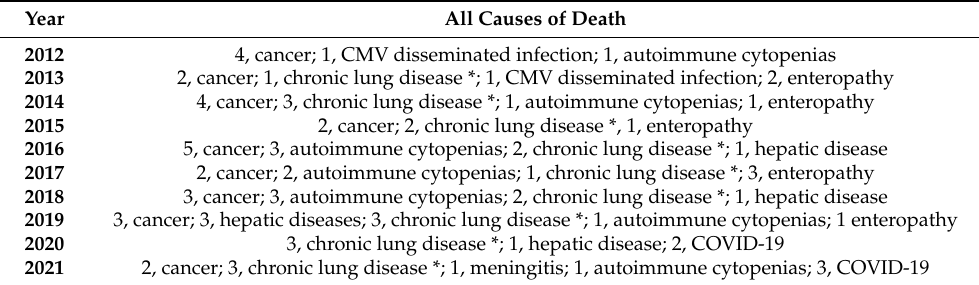
Table 4. Number of patients dead for a given cause observed in the last 10 years in the cohort of Italian PADs patients.